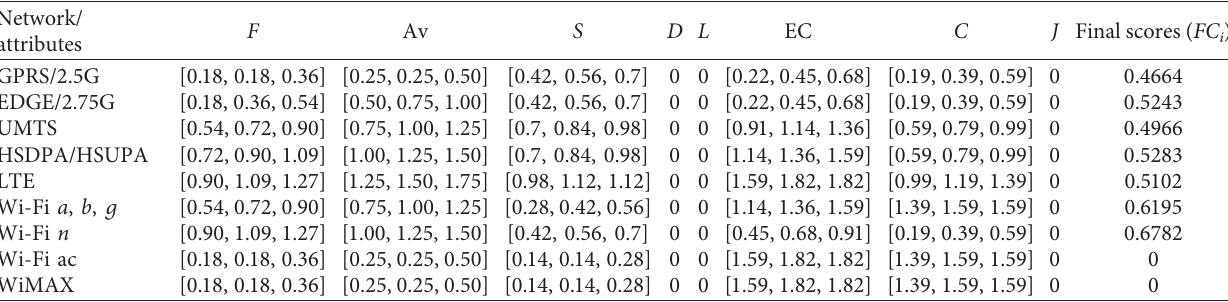
Table 10: Weighted fuzzy values with final fuzzy scores FCi.